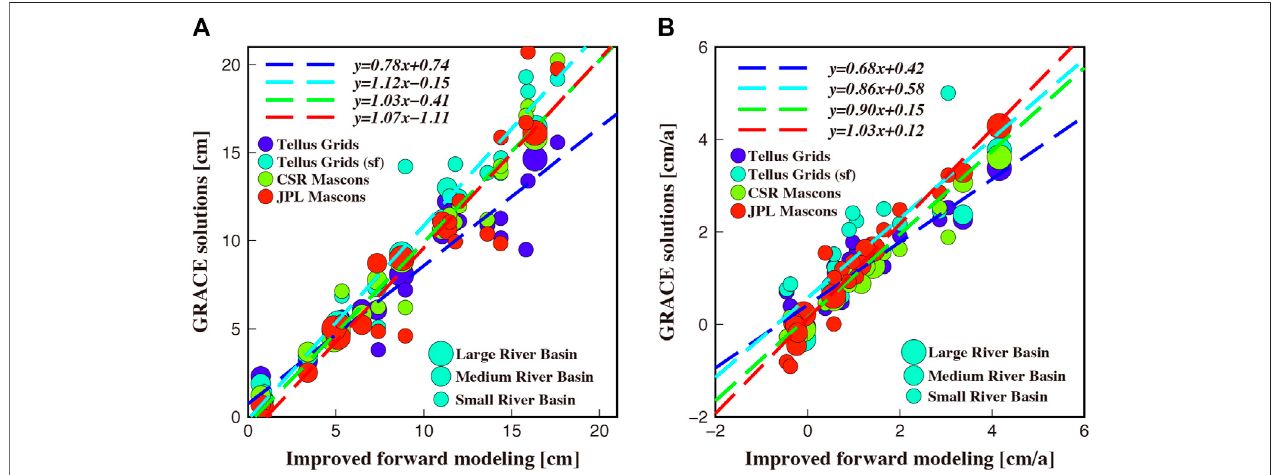
FIGURE 12 | Scatter plots of annual amplitudes (A) and trends (B) for the comparisons of improved forward modeling and other GRACE datasets. The GRACE datasets include CSR Tellus grids, CSR Tellus grids with scale factor, CSR mascons, and JPL mascons. The regression lines are determined with 95% con fi dence bounds.